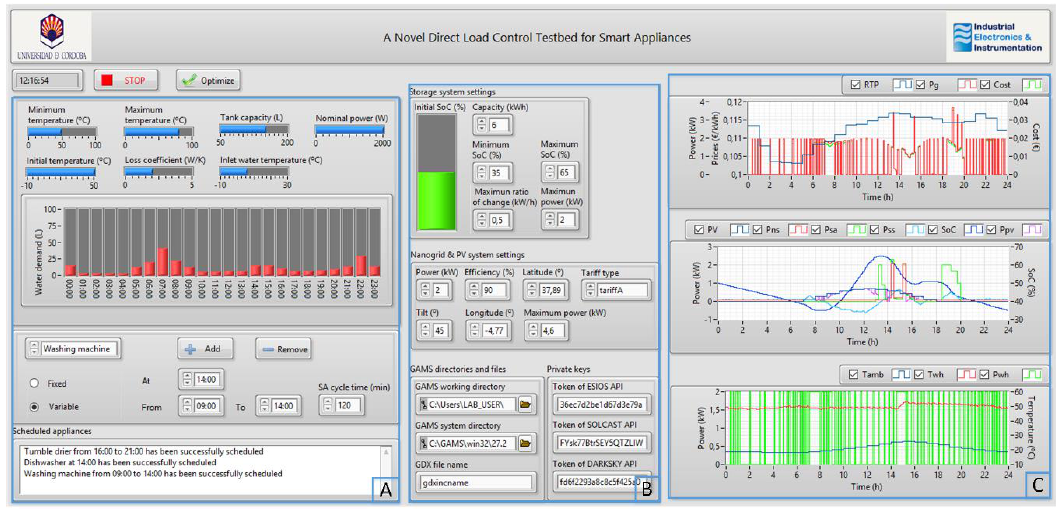
Figure 2. LabVIEW graphic user interface (GUI). 244